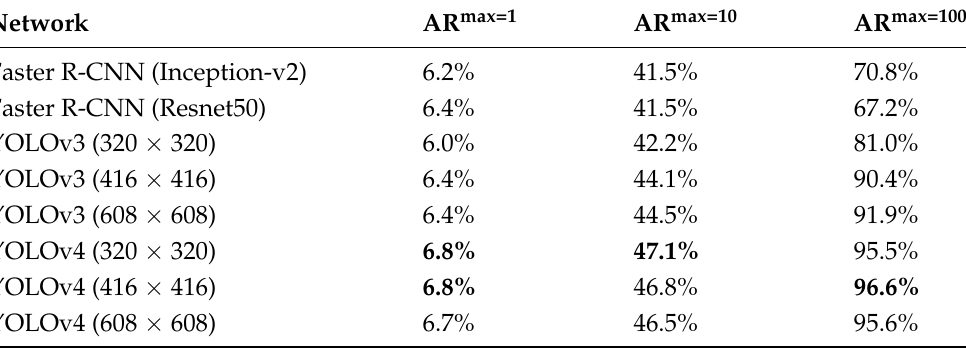
Table 9. Average recall for a given maximum number of detections, averaged over all values of IoU (0.5, 0.6, 0.7, 0.8, and 0.9), on the PSU (Prince Sultan University) dataset. The best results are marked in